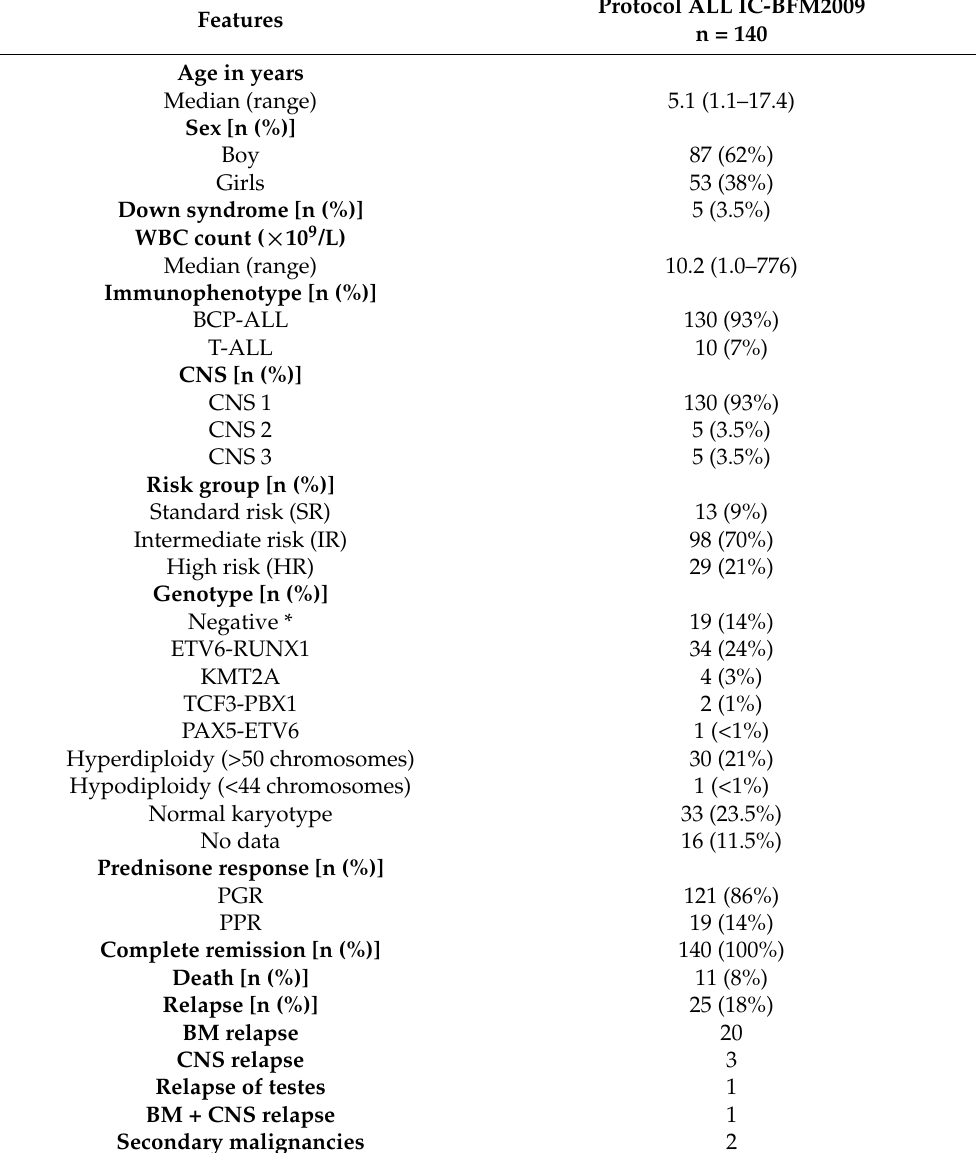
Table 3. Clinical and laboratory characteristics of study